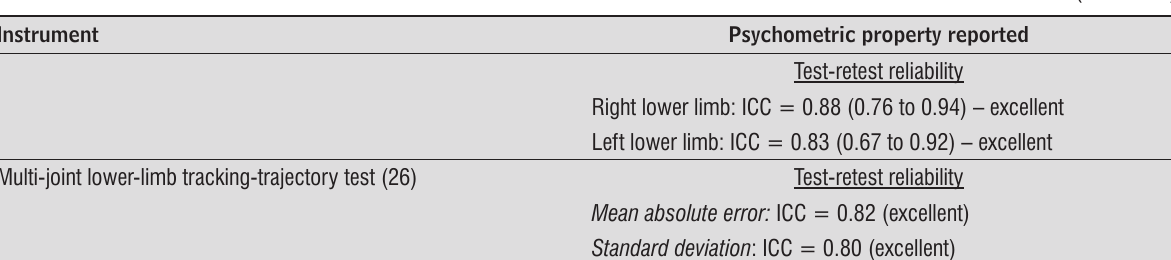
Table 2 - Values of the psychometric properties of the specific tests for the evaluation of lower limb motor coordination, re- ported by the studies included in the review